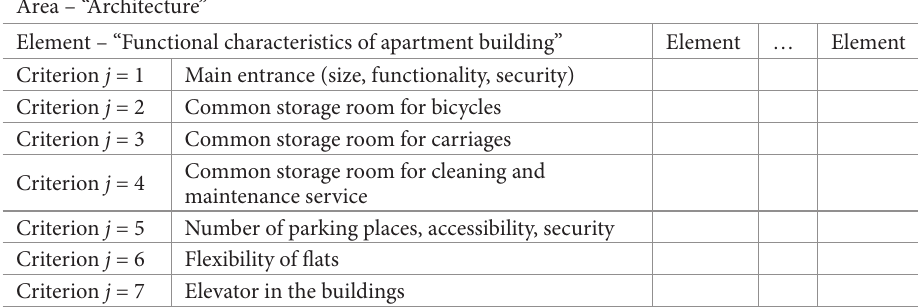
Table 4. Overview of criteria within “Energy efficiency” element of the area “Building physics” as used